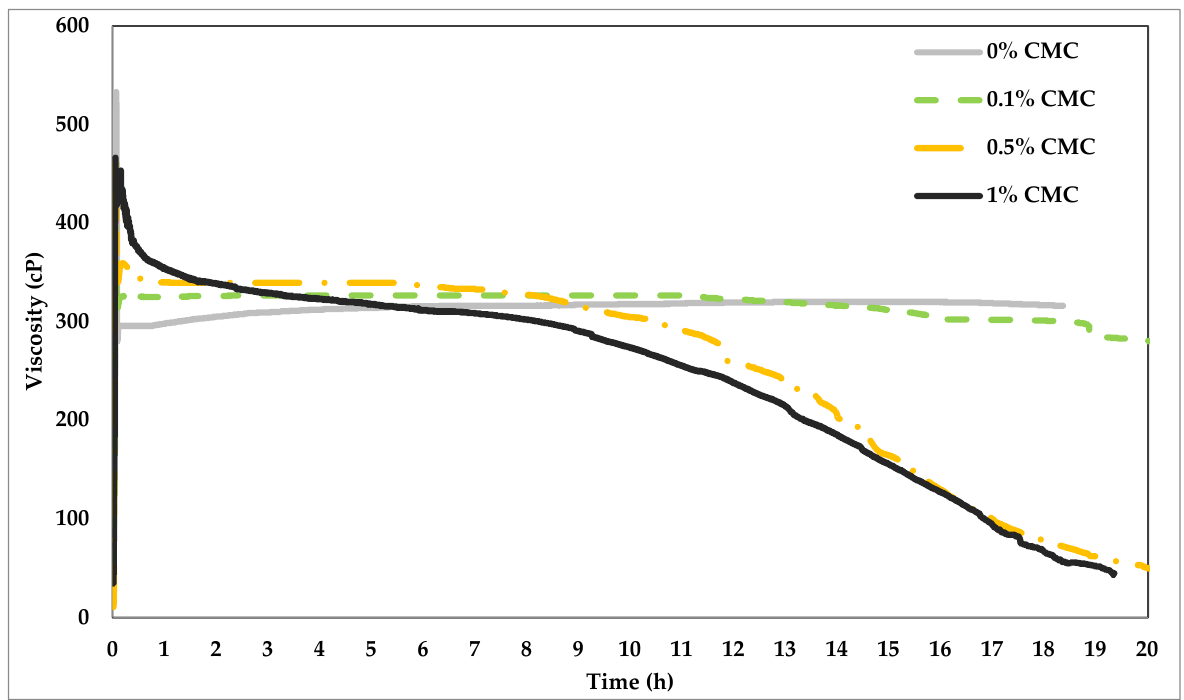
Figure 6. T he viscosity changes with respect to time for 9% ( v/v ) VES at different CMC concentra- tions at 300 F. Figure 6. The viscosity changes with respect to time for 9% ( v / v ) VES at different CMC concentrations at 300